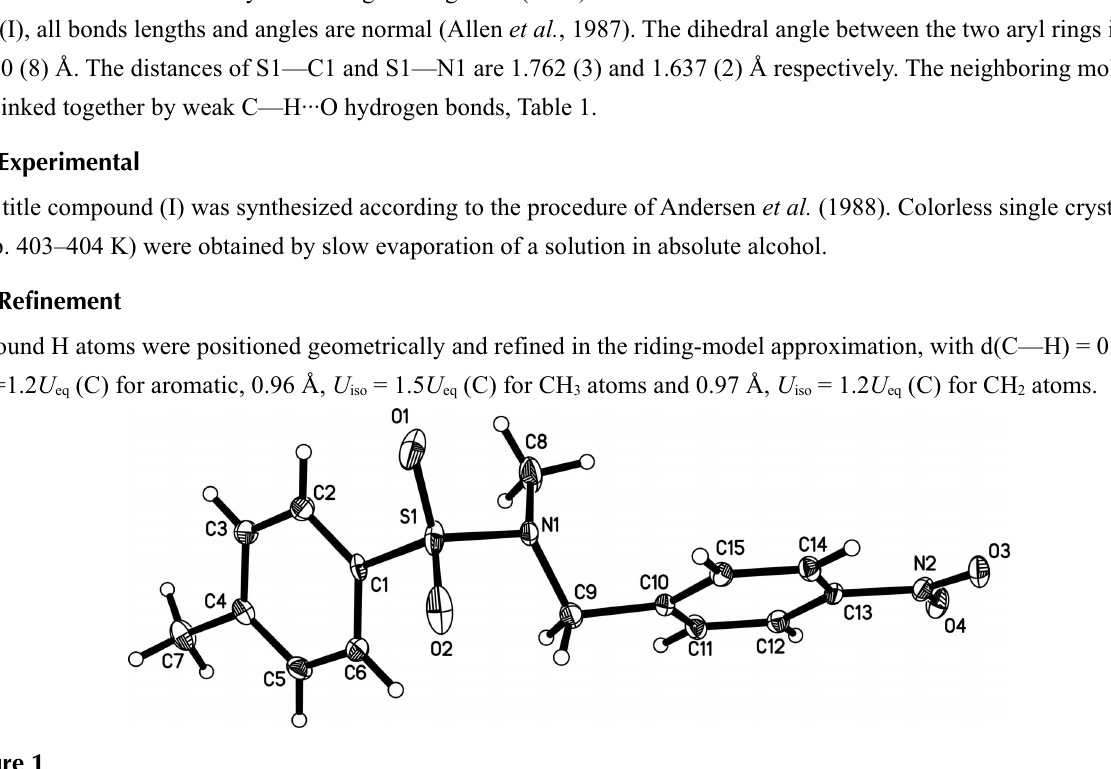
The structure of (I) with displacement ellipsoids drawn at the 30% probability level and H atoms shown as small spheres of arbitrary